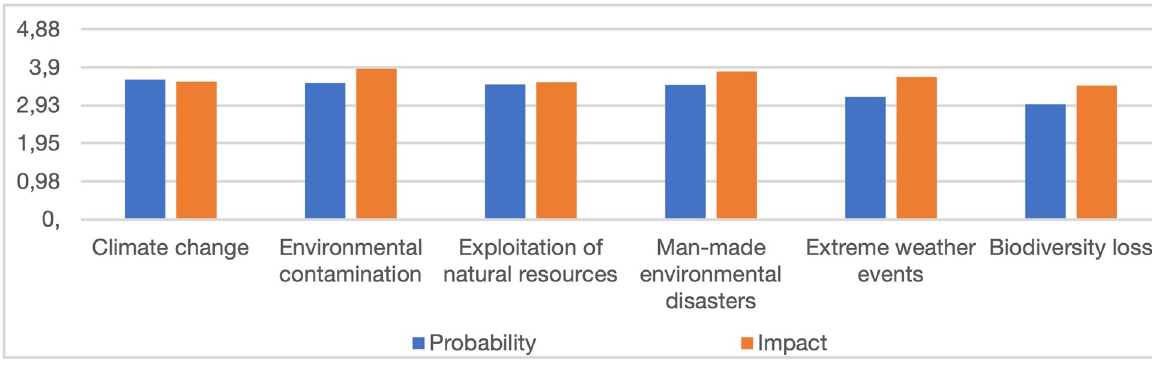
Fig 1. Average scores for the probability of individual environmental risks and their social and economic impact in